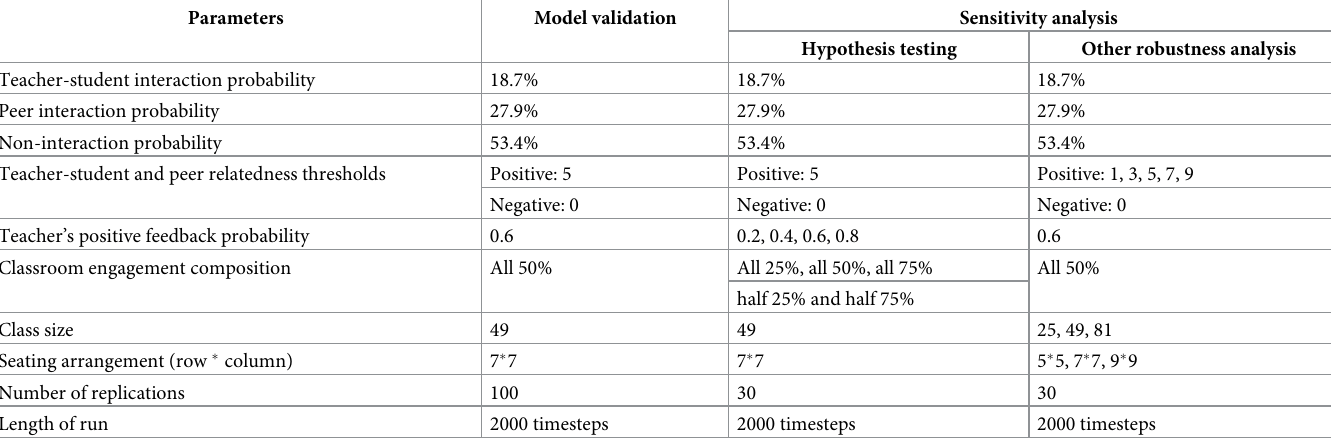
Table 2. Parameters of the